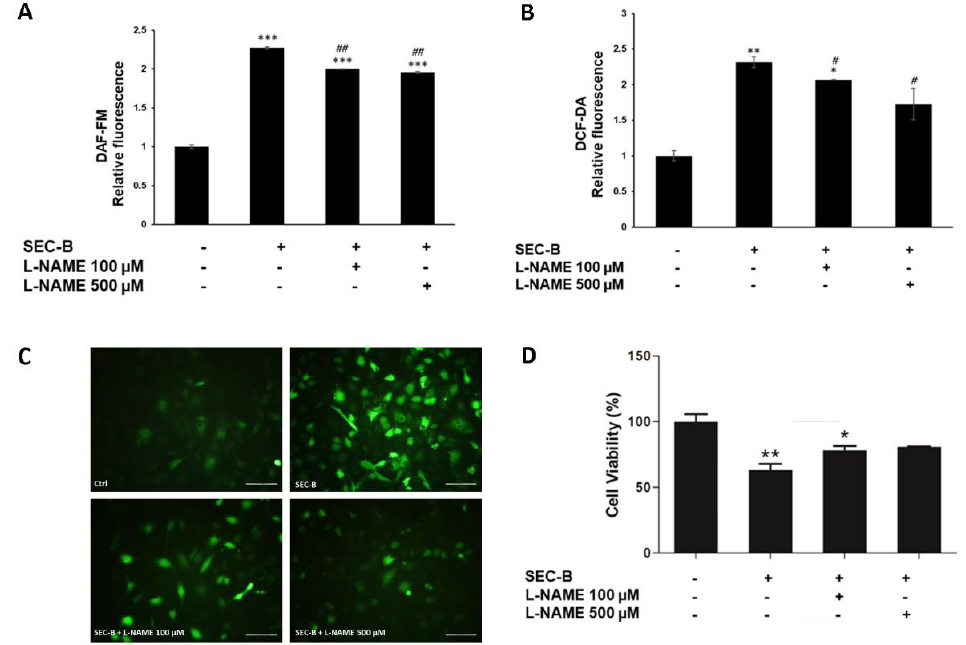
Figure 6. Inhibition of NOS decreases NO and ROS production and increases HMEC-1 cell survival. ( A ) Pre-treatment with L-NAME (100 µM and 500 µM) decreases intracellular NO levels in HMEC-1 cells after 4 h of SEC-B administration. ( B ) Pre-treatment with L-NAME decreases intracellular ROS levels in HMEC-1 cells after 4 h of SEC-B administration. ( C ) Representative microscopy images of HMEC-1 labeled with DCF-DA probe after 1 h of pre-treatment with L-NAME followed by 4 h of SEC-B treatment. The images are obtained by optical fluorescence microscopy using the 20× objective. Scale bar: 100 µm. ( D ) Cell viability evaluation after 1 h of pre-treatment with L-NAME followed by 24 h of SEC-B treatment. Data are expressed as mean ± SD ( n = 3). * p < 0.05, ** p < 0.01, *** p < 0.001 vs. untreated cells; # p < 0.05, ## p < 0.01 vs . SEC-B-treated cells.